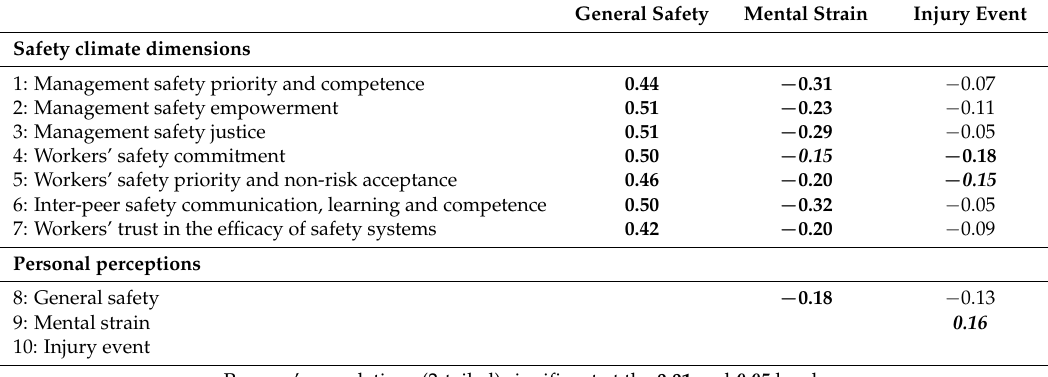
Table 2. The dimensions of safety climate in relation to personal perceptions of safety, mental strain and injury